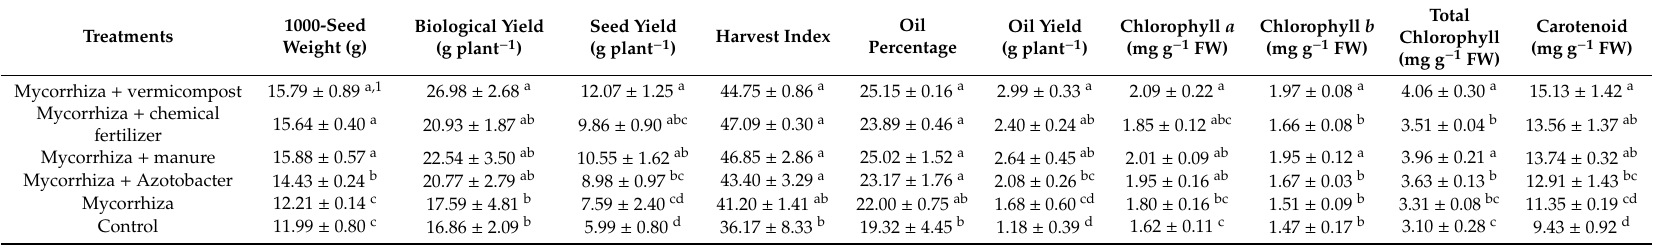
Table 4. Agrobiological properties of Syrian cephalaria as influenced by organic and chemical fertilizers. Treatments